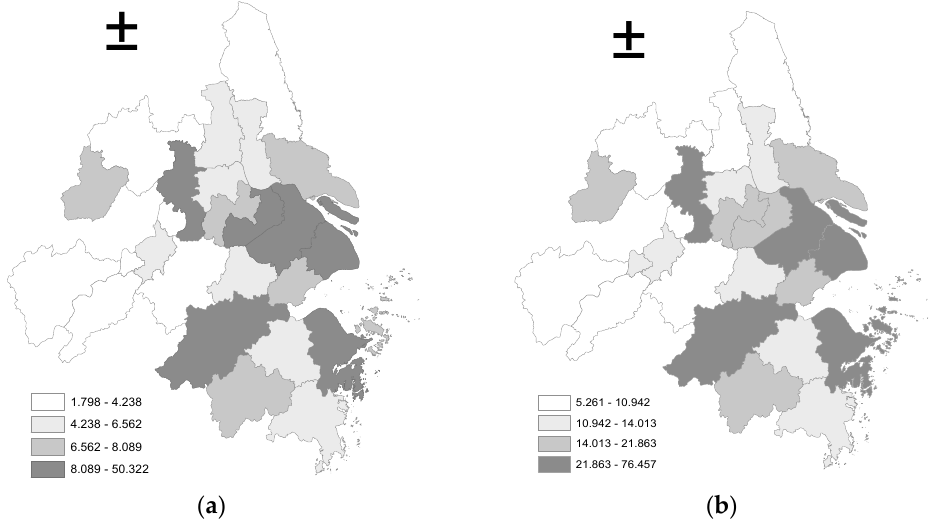
Figure 1. Quaternary Map of the Development of Logistics Industry in Yangtze River Delta: ( a ) 2005; ( b ) 2015.